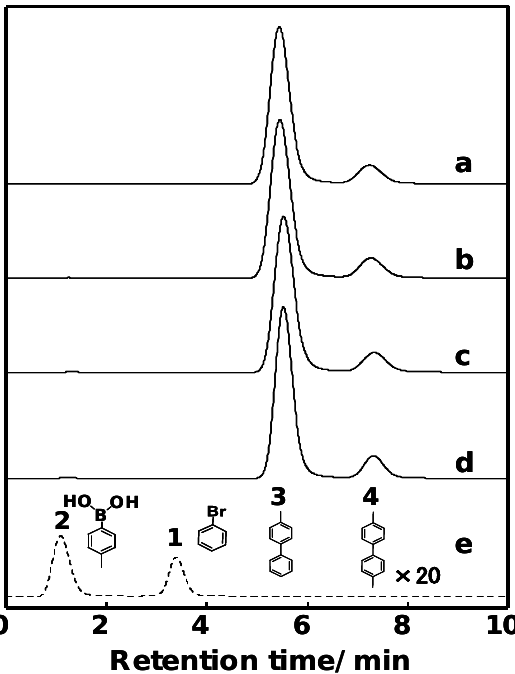
Figure 3. Chromatogram of the cross-coupling products of the Suzuki–Miyaura reaction at different reaction times. Mole ratio of bromobenzene/4-methylphenylboronic acid/Na 3 PO 4 = 1:1:1, microreactor: M1, reaction times: 12 s ( a ), 60 s ( b ), 300 s ( c ), 600 s ( d ), 0 s ( e ), reaction temperature: 27 °C.